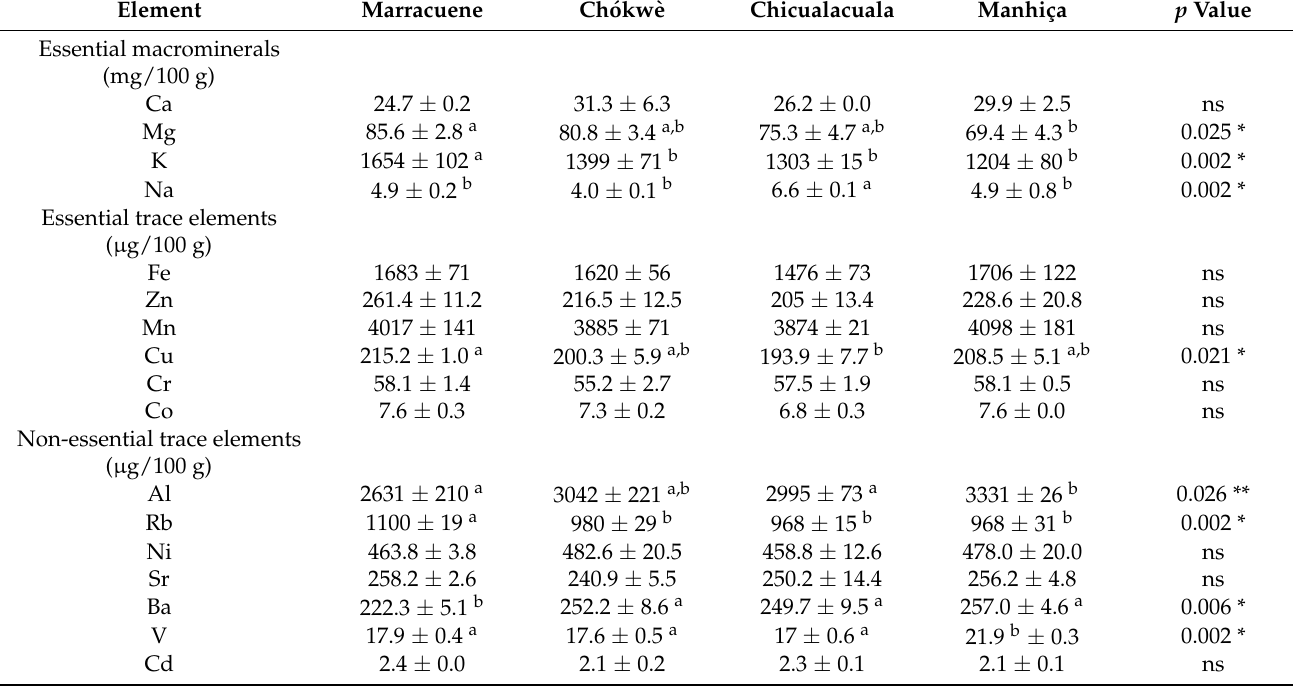
Table 5. Mineral composition of the S. madagascariensis fruit flour ( nfuma ) from four districts (Mar- racuene, Manhiça, Ch ó kw è and Chicualacuala) in southern